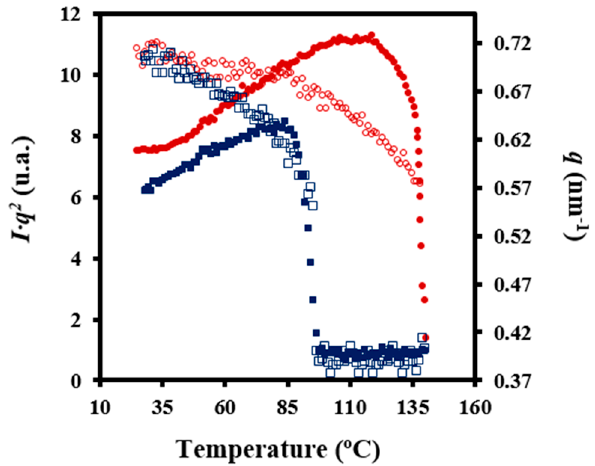
Figure 9. Variation of intensity ( Iq 2 ) (full symbols) and scattering vector ( q ) (empty symbols) of SAXS (small-angle X-ray scattering) peaks observed in the diffraction profiles taken during heating (10 °C/min) at room temperature (red) and during cooling (2 °C/min) from the melt state (blue). Characteristic lamellar parameters (i.e., long period, L γ , amorphous layer thickness, l a , and